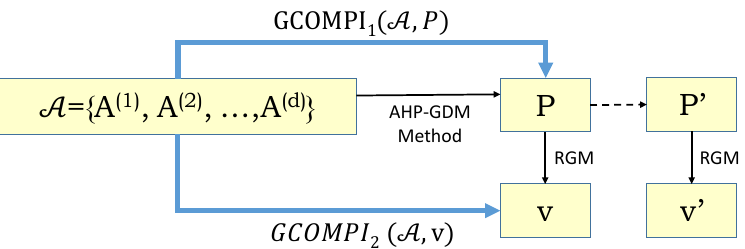
Figure 2. Outline of the incompatibility reduction of indicators GCOMPI 1 and GCOMPI 2